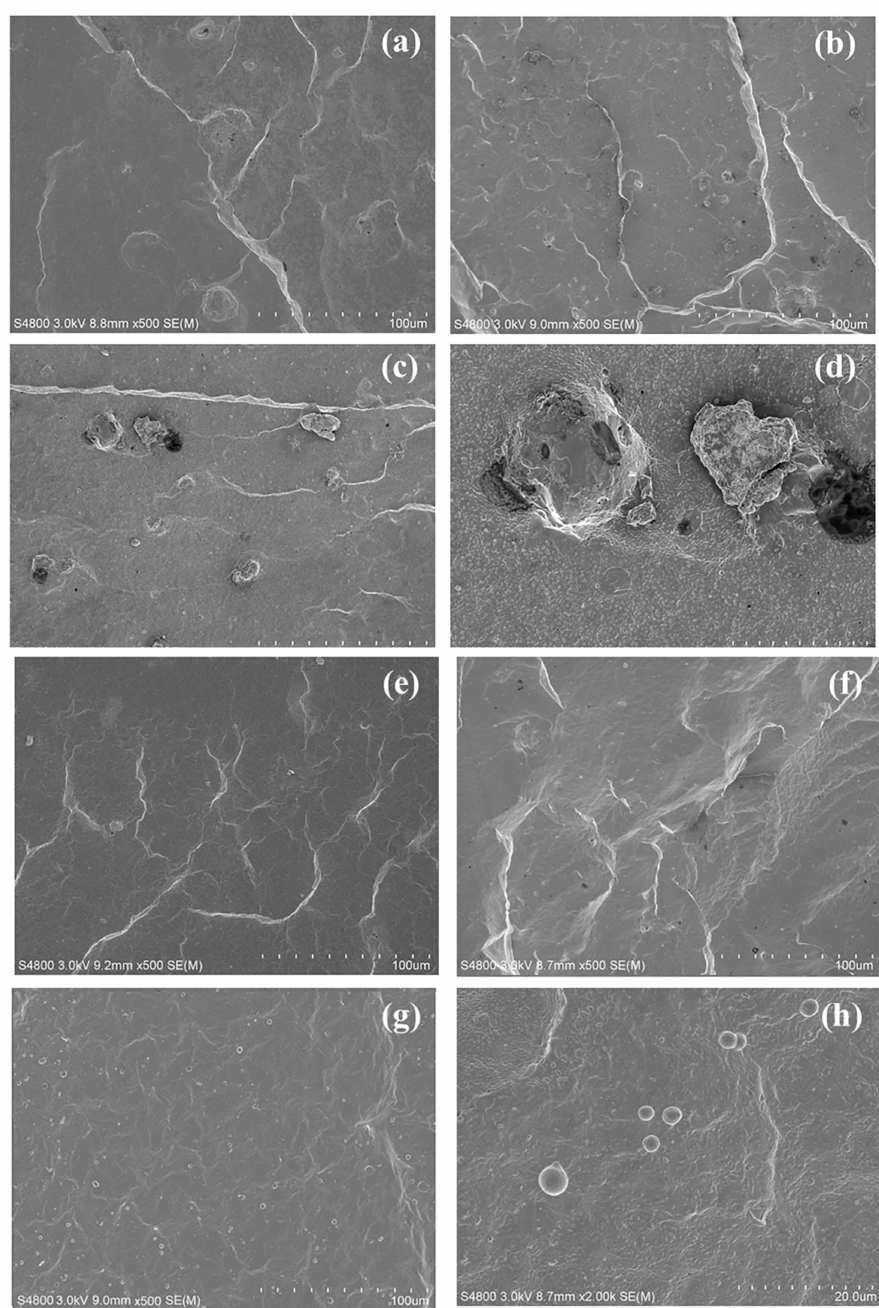
Figure 15. FE-SEM images of NR/OPA at different loading levels of ( a ) 1 phr, ( b ) 5 phr and ( c ) 10 phr at 500 × magnification and ( d ) 10 phr at 2000 × magnification and NR/tOPA at different loading levels of ( e ) 1 phr, ( f ) 5 phr and ( g ) 10 phr at 500 × magnification and ( h ) 10 phr at 2000 ×